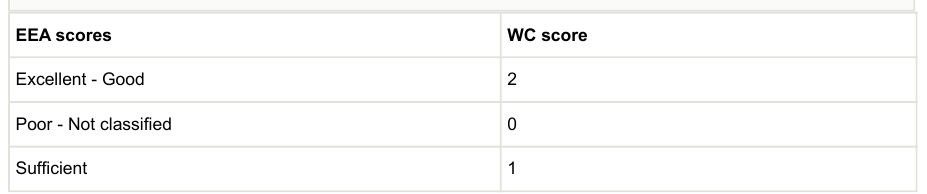
Scores used for bathing water quality